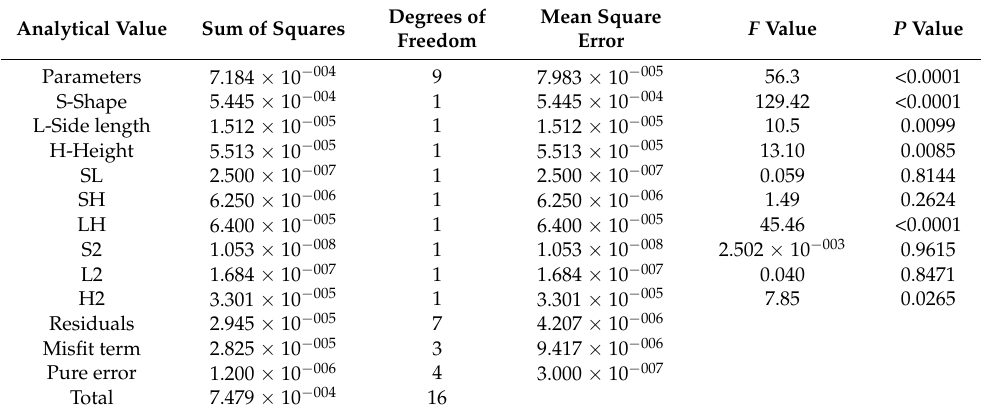
Table 12. Analysis of variance of cubic regression equation of average friction coefficient.